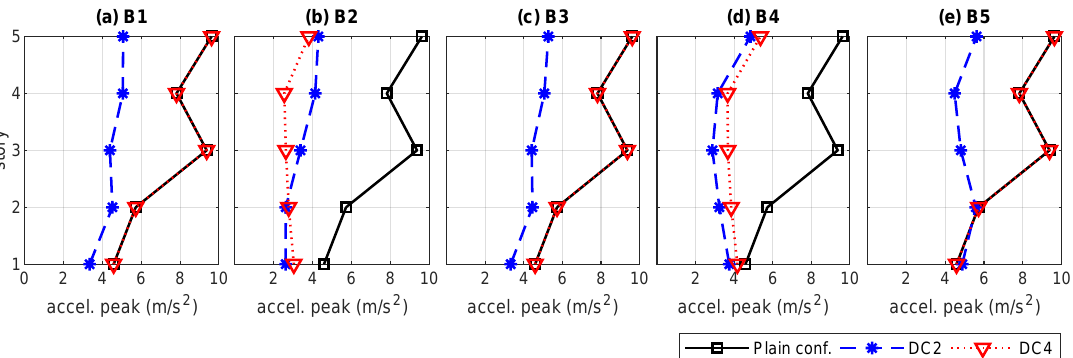
Figure 14. Maximum absolute story total-accelerations attained by the nonactuated multibuilding system (plain configuration), the linked configuration DC2 and the unlinked configuration DC4.